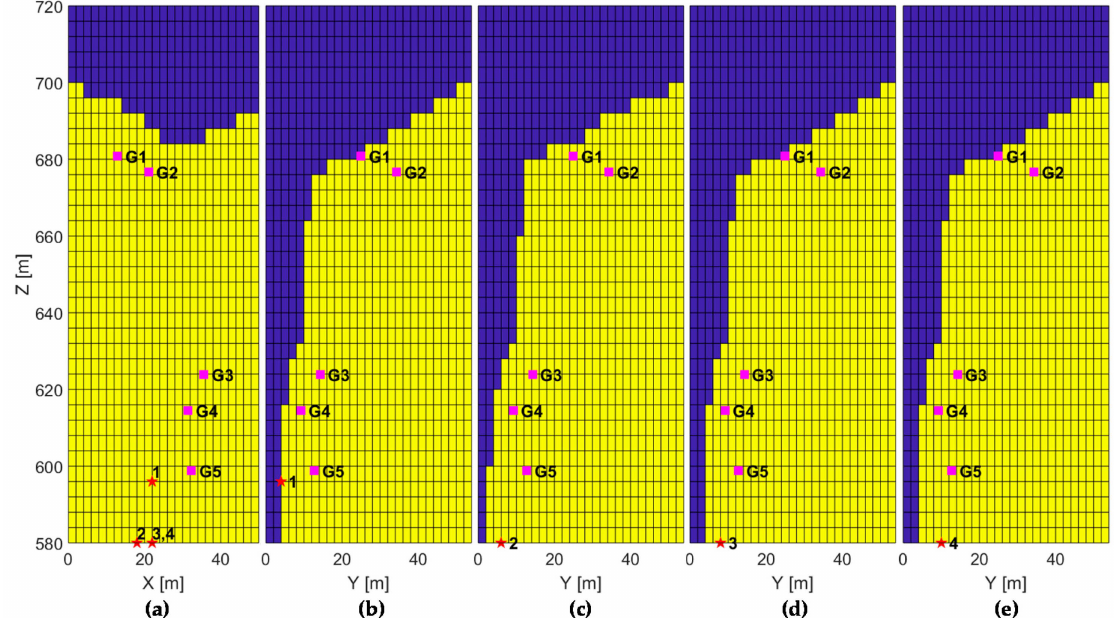
Figure 7. Location results for Rockfall event 1 (Single) presented on vertical slices. ( a ) Vertical slice in the front view (Y = 32 m). The blue area is the air, and the yellow area is the rock mass. Pink squares indicate the five 3C geophones projected on the slice. Red stars indicate the event locations projected on the slice and numbers are used to order the signals according to the arrival times. ( b – e ) Vertical slices cutting through the location of each signal in the side view to show the distance between the hypocenter location and the rock